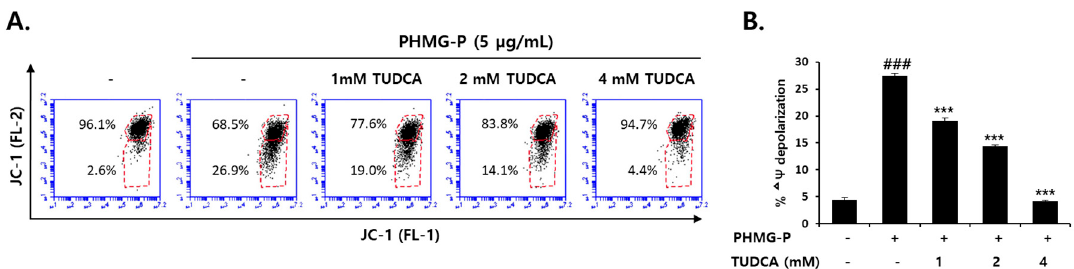
Figure 8. The inhibition of PHMG-P-induced mitochondrial dysfunction by the ER stress inhibitor, TUDCA. ( A ) The cells were pretreated with TUDCA and then treated with 5 µg/mL PHMG-P for 24 h prior to FACS analysis of JC-1 staining. ( B ) The quantification of mitochondrial membrane potential ( ΔΨ ) is presented from three independent experiments. Each value represents the mean ± SD. (### p < 0.001, significant versus control; *** p < 0.001, significant versus PHMG alone).